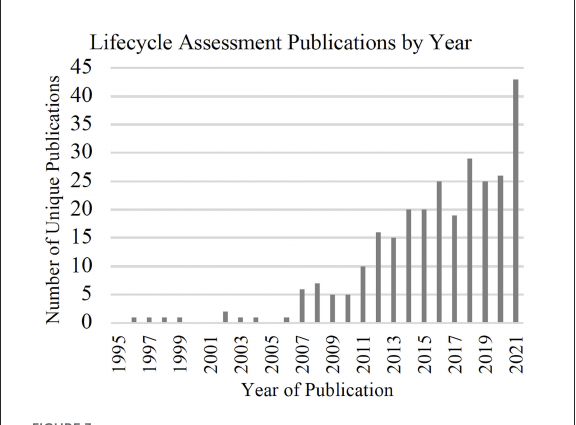
FIGURE2 Brief outline of LCA’s methodological history.